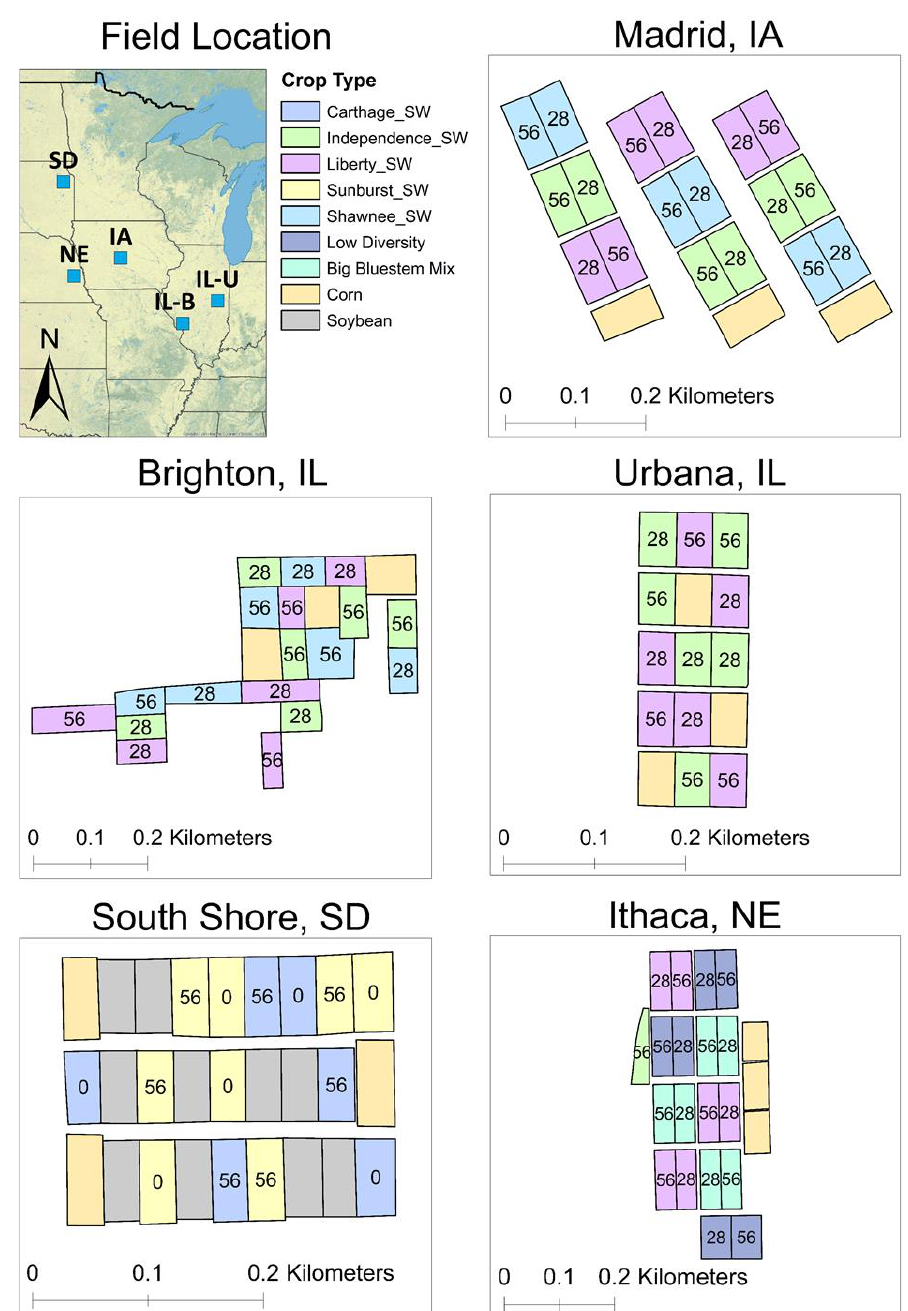
Figure 1. Field site locations in the U.S. Midwest and the plot layouts across the Brighton, Illinois (IL); Urbana, IL; Madrid, Iowa (IA); Ithaca, Nebraska (NE); and South Shore, South Dakota (SD) sites. Plots are labeled by crop/cultivar type (SW = switchgrass, Panicum virgatum L.) and annual nitrogen application (0, 28, or 56 kg N ha −1 ). The big bluestem ( Andropogon gerardii Vitman) mixture includes ‘ Goldmine ’ and ‘ Bonanza ’ big bluestem cultivars. The low diversity mixture includes side-oats grama ( Bouteloua curtipendula (Michx.) Torr.), Indiangrass ( Sorghastrum nutans ), and big bluestem.